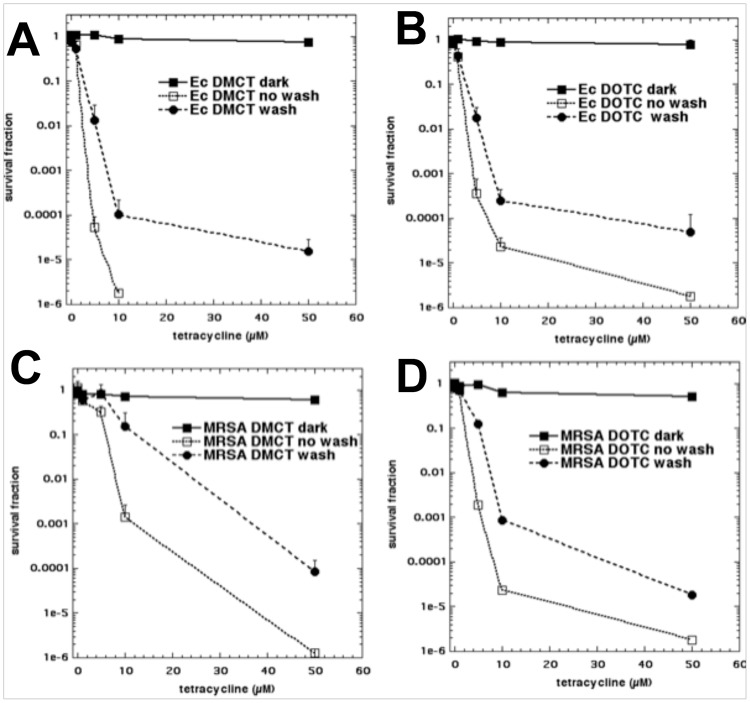
Effect of a wash-step on aPDI with tetracyclines.Bacterial cells were incubated for 30 min in PBS with stated concentration of tetracycline and either exposed (or not “dark”) to 10 J/cm2 of the appropriate light (“no wash”), or centrifuged and resuspended in fresh PBS and exposed to 10 J/cm2 (“wash”). (A) E. coli UTI89, DMCT and BL; (B) E. coli UTI89, DOCT and UVA; (C) MRSA, DMCT and BL; (D) MRSA, DOTC and UVA.